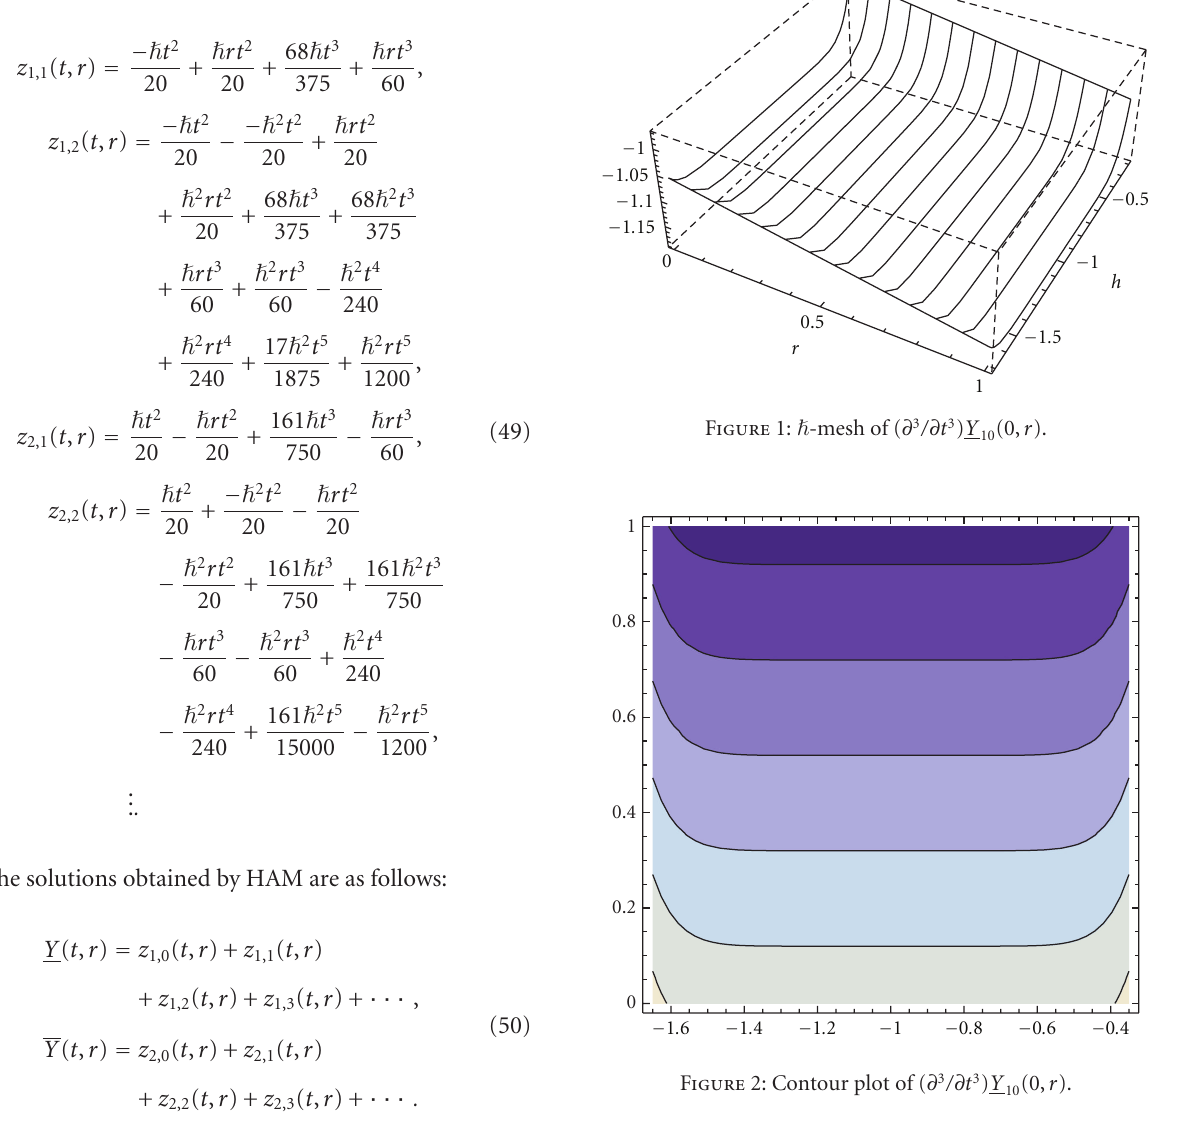
Figure 2: Contour plot of ( ∂ 3 /∂t 3 ) Y